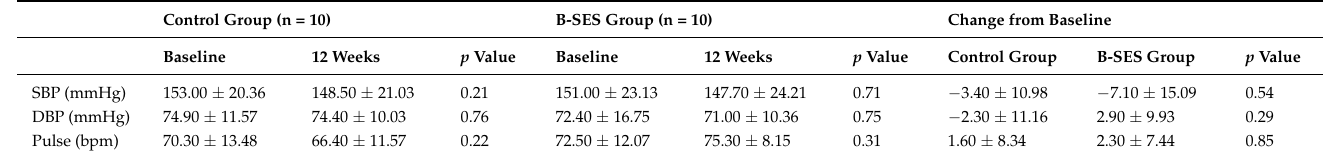
Table 2. Resting vital